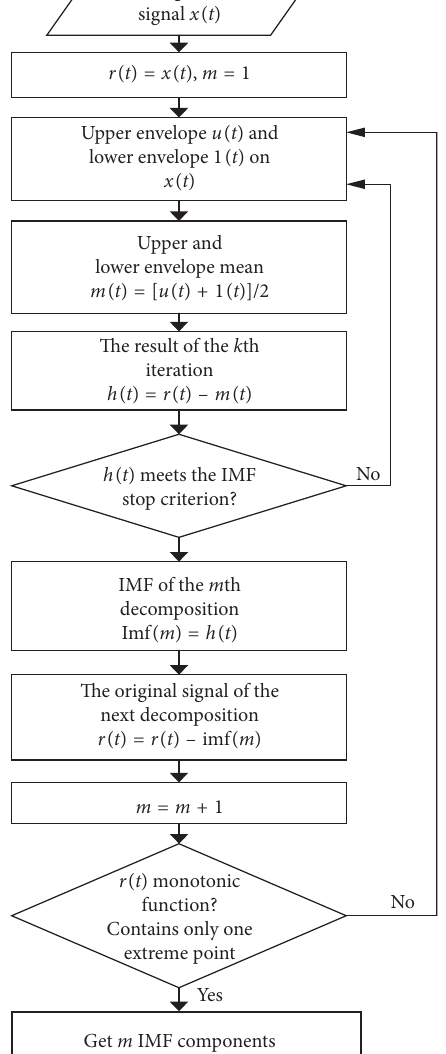
Figure 9: Flowchart for obtaining EMF components by EMD.